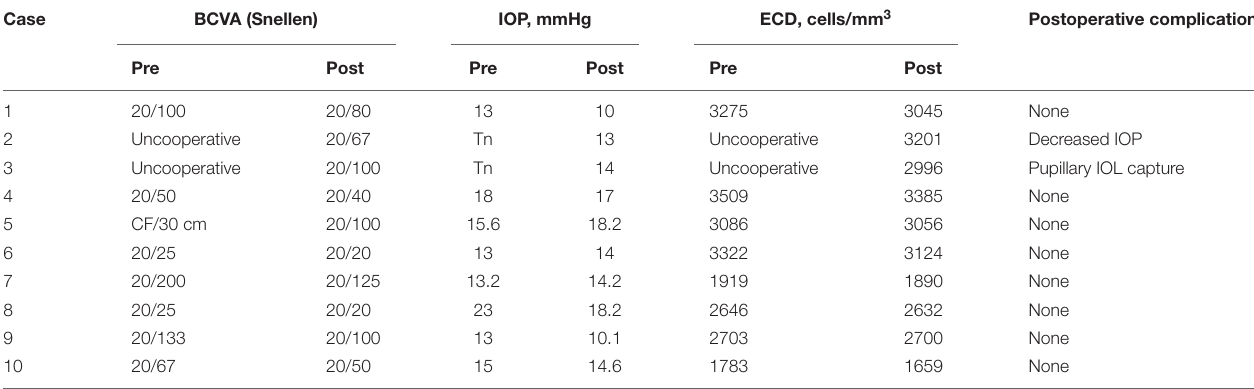
RD, retinal detachment; CD, choroidal detachment. TABLE 2 | Comparison of clinical data before and after surgery.